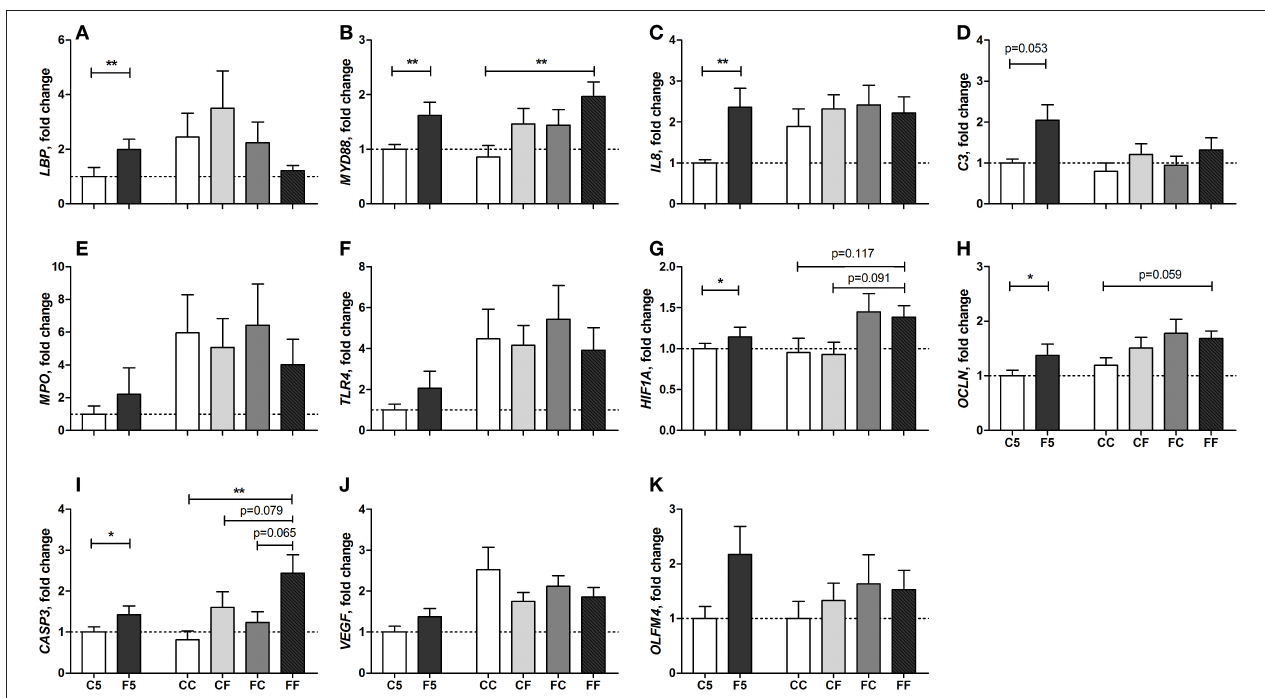
FIGURE 7 | Fold change of intestinal gene expression levels relative to the C5 group. LBP (A) , MYD88 (B) , IL8 (C) , C3 (D) , MPO (E) , TLR4 (F) , HIF1A (G) , OCLN (H) , CASP3 (I) , VEGF (J) , OLFM4 (K) in the distal small intestine. Values (means ± SEM) designated with asterisks are significantly different, * P < 0.05, ** P < 0.01. n = 8 each for C5 and F5 groups, and n = 9–13 for CC, CF, FC, and FF groups. C5, colostrum feeding until day 5; CC, colostrum feeding until day 9; CF, 4 days colostrum feeding followed by formula feeding until day 9; F5, formula feeding until day 5; FC, 4 days formula feeding followed by colostrum feeding until day 9; FF, formula feeding until day